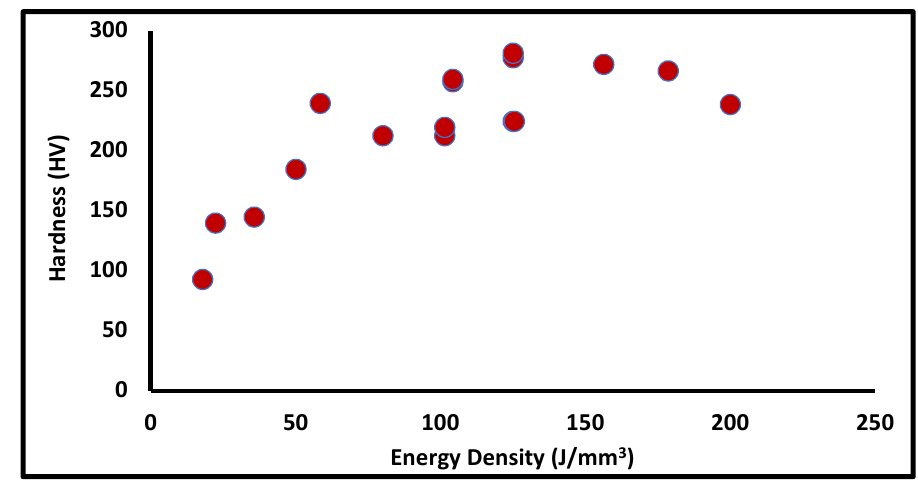
Figure 7. Hardness at different energy density.